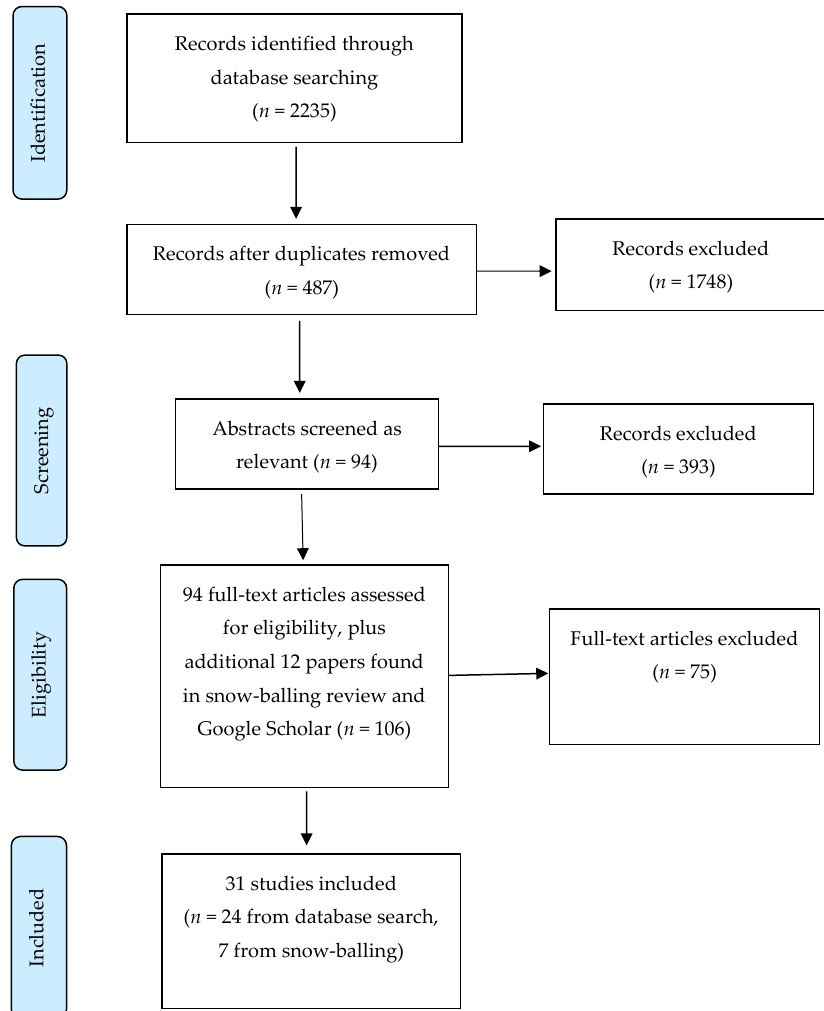
Figure 1. The Preferred Reporting Items for Systematic Reviews and Meta-Analyses (PRISMA) flowchart of the article selection.